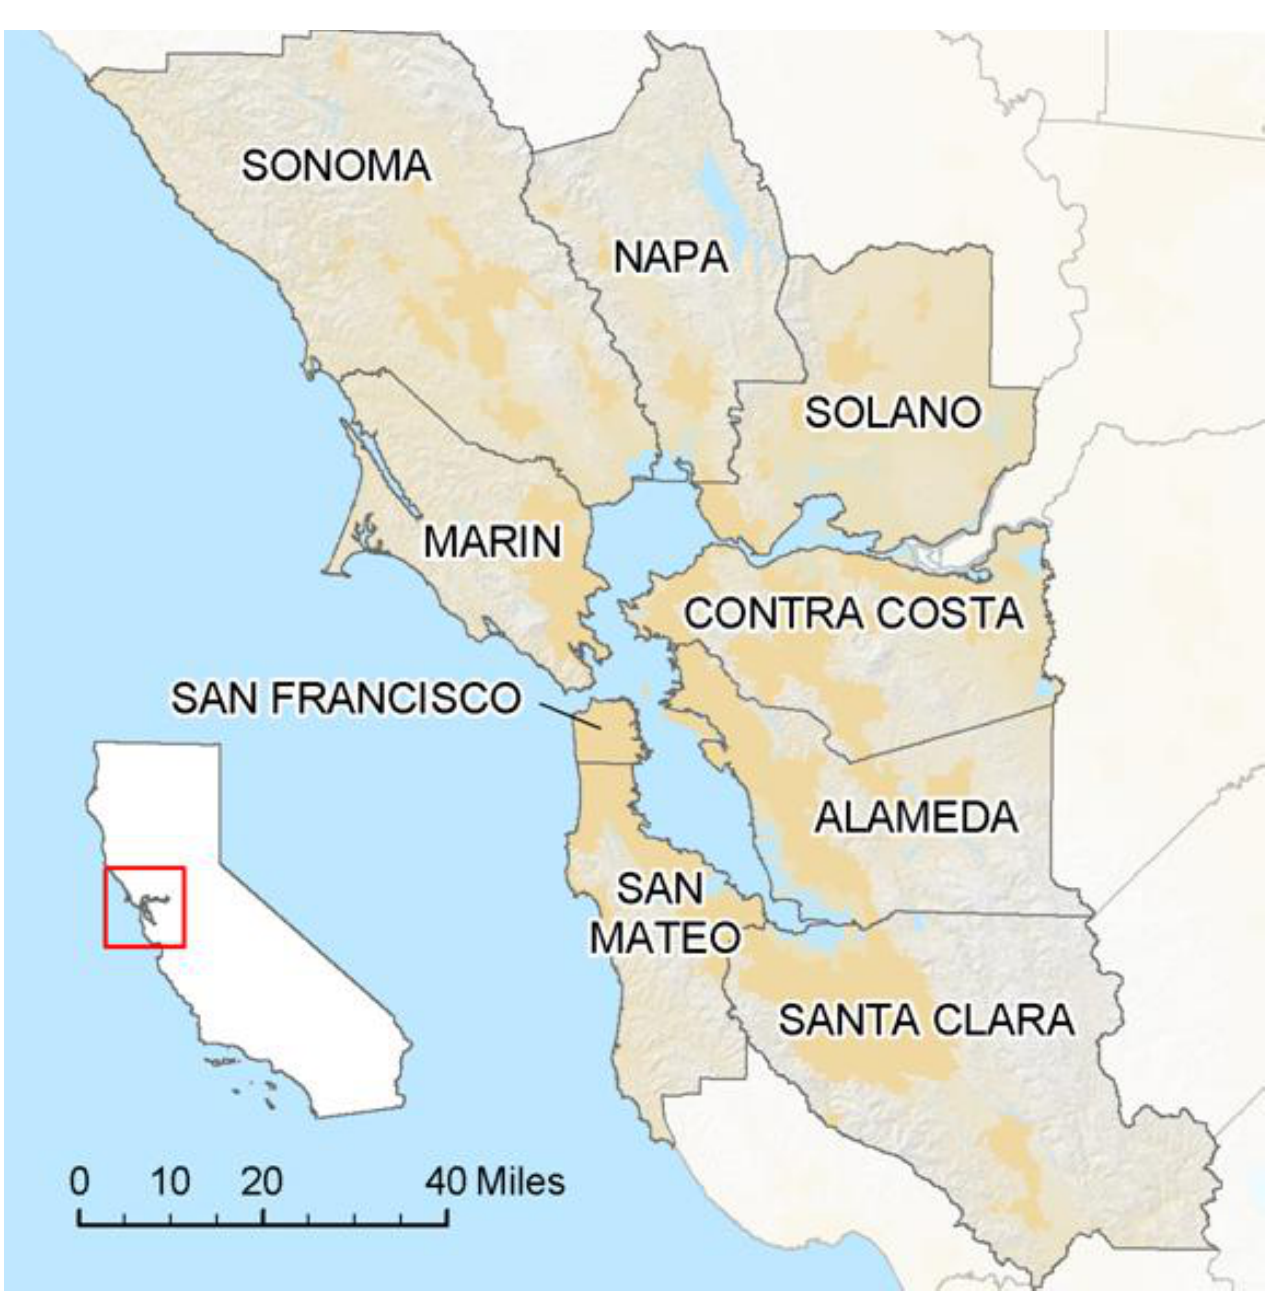
Fig. 1 . The nine-county San Francisco Bay